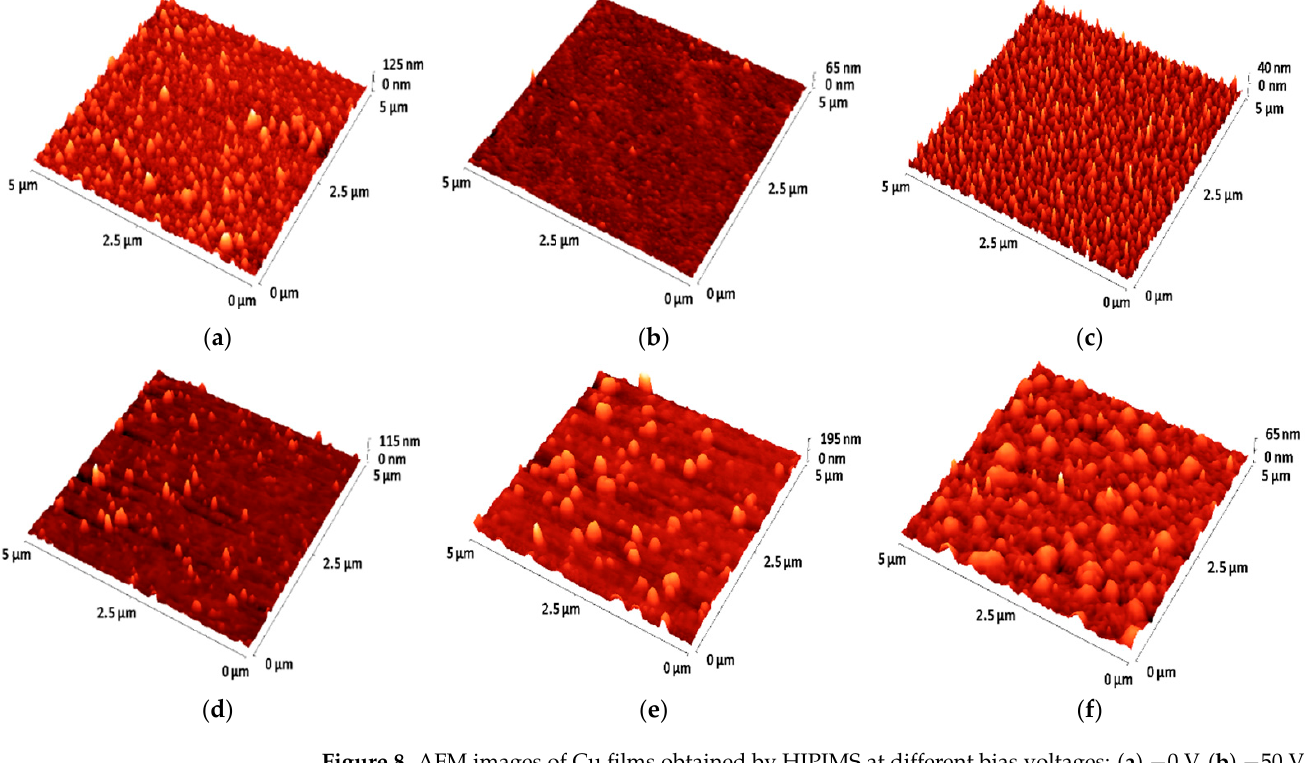
Figure 8. AFM images of Cu films obtained by HIPIMS at different bias voltages: ( a ) − 0 V, ( b ) − 50 V, ( c ) − 100 V, and by DC sputtering: ( d ) − 0 V, ( e ) − 50 V, ( f ) − 100 V.